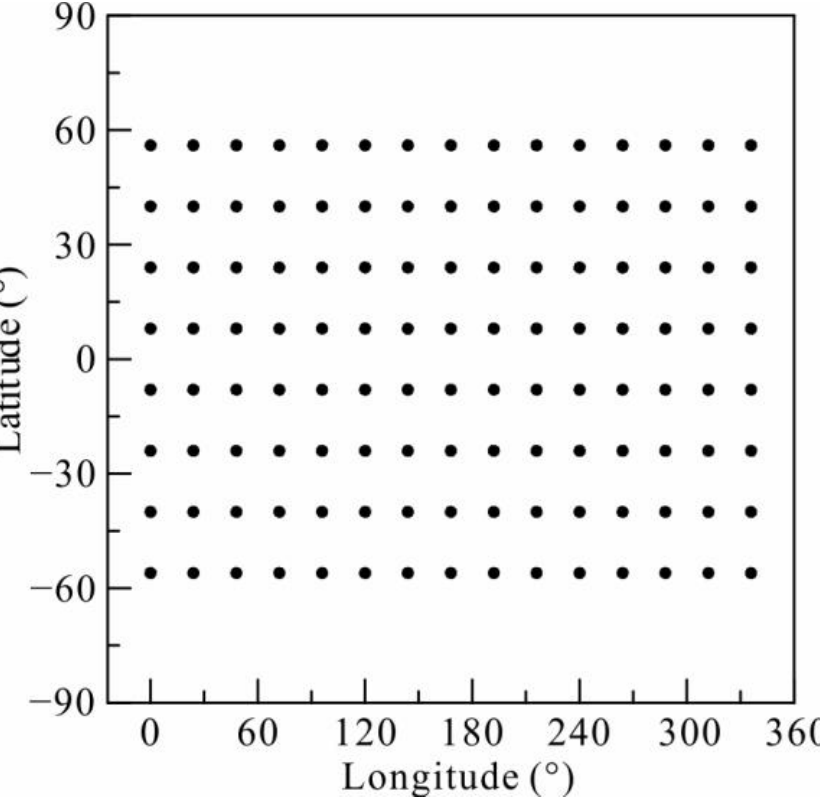
Figure 4. Regular network with 120 stations used in this